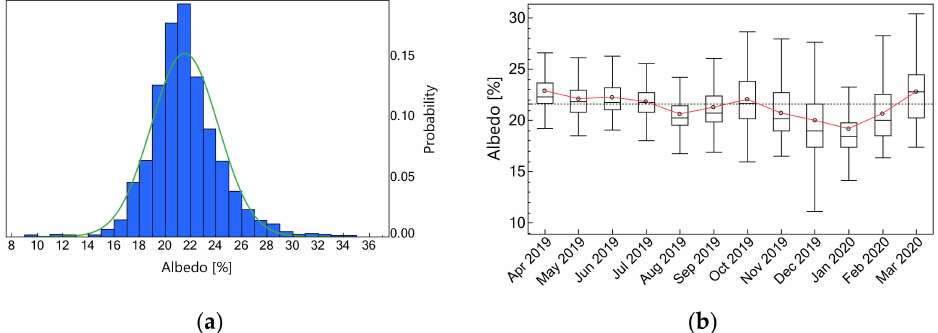
Figure 4. ( a ) Distribution of albedo measurements made during the one-year period; ( b ) Box and whisker plots of the monthly albedo, the red line connects the mean monthly albedo, the dashed reference line shows the annual average of